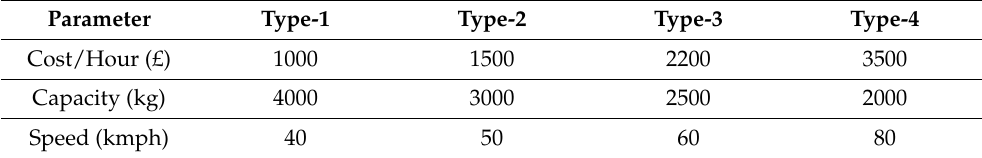
Table 3. Vehicle parameters of each type at supply